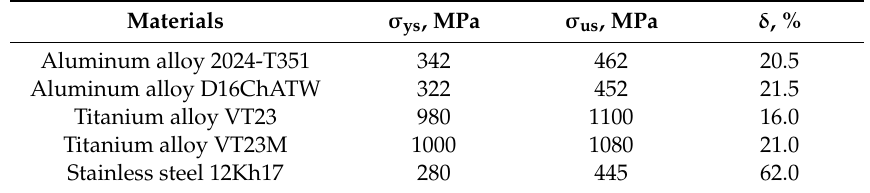
Table 1. Mechanical properties of materials studied.